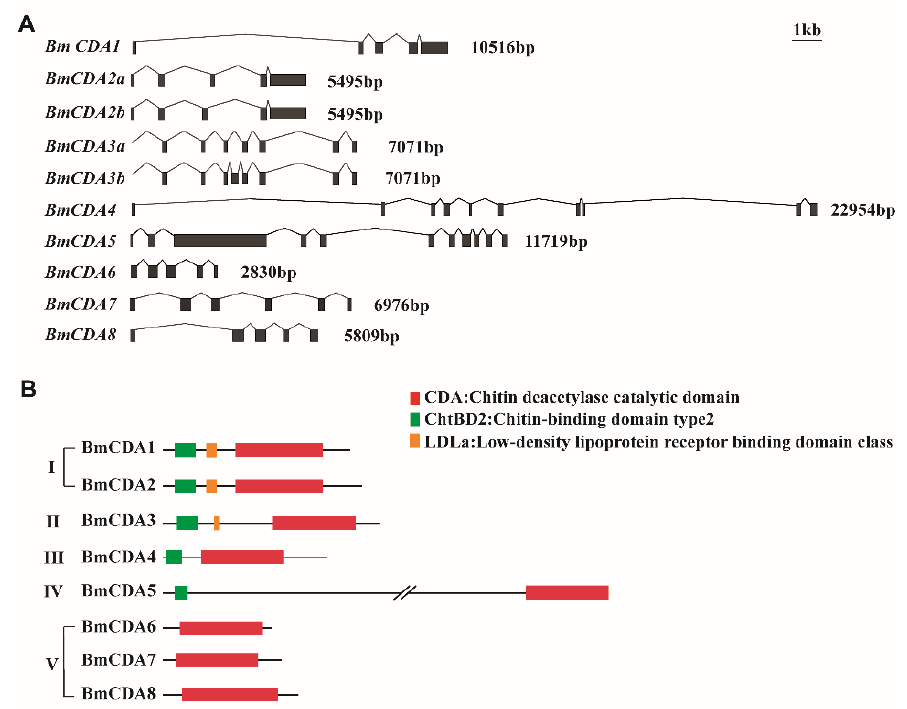
Figure 1. ( A ) Schematic diagram of the exon–intron organizations of eight Bombyx mori chitin deacetylase ( BmCDA ) genes. The exons are shown in gray boxes. The lines between the boxes indicate the introns. ( B ) Schematic diagram of the domain architectures of eight BmCDA genes. Red boxes indicate chitin deacetylase catalytic domains; green boxes indicate chitin-binding domain type 2; orange boxes indicate low-density lipoprotein receptor binding domain